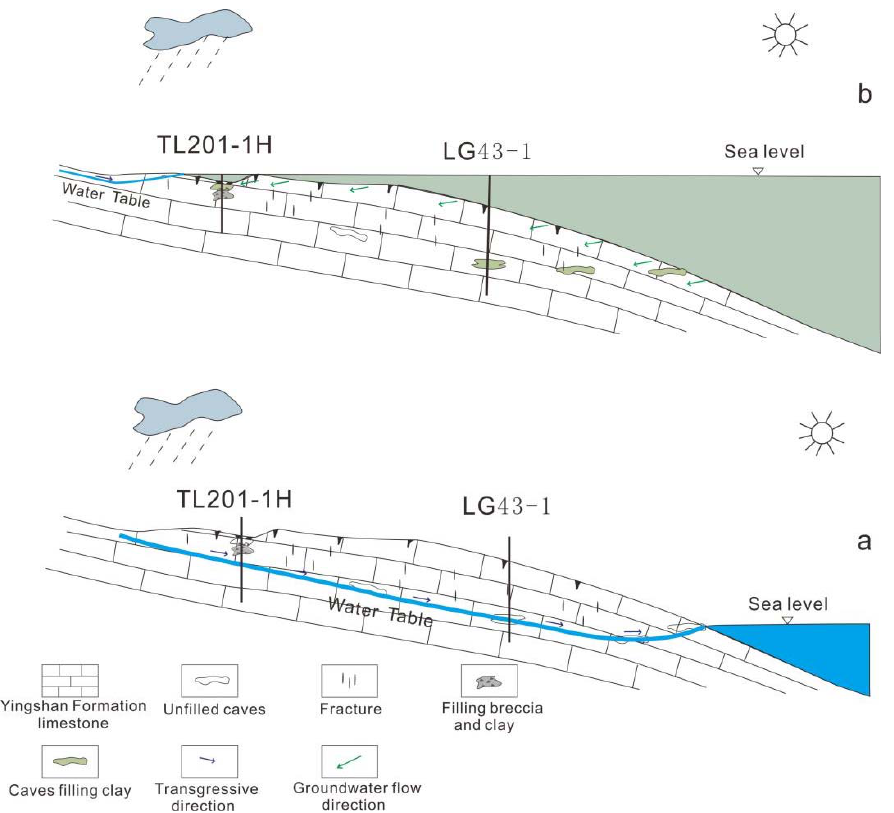
Figure 11. Karst cave filling pattern of Yingshan Formation in the northern slope of Tazhong. ( a ) The exposed period of Yingshan Formation is dominated by karstification, karst breccia, and clay filling into the cave; ( b ) during deposition of the Lianglitage Formation after exposure, seawater invaded the cave, and mud was brought into the filling cave with seawater.